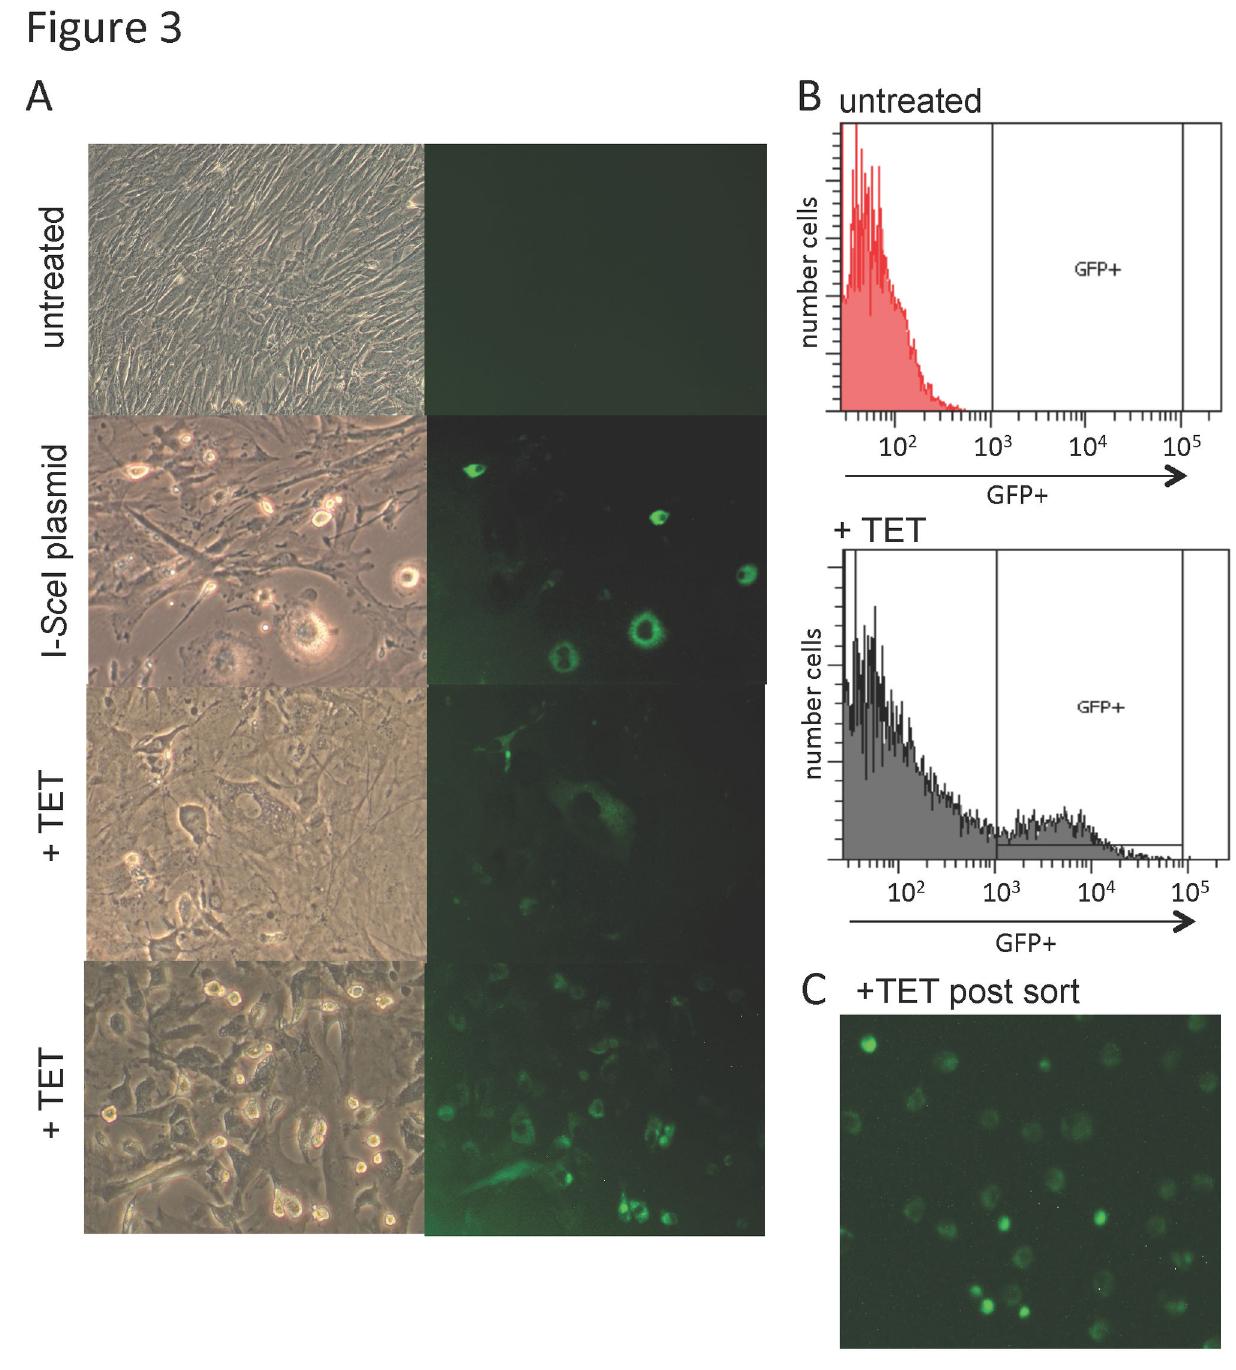
Figure 3. Analysis of GFP+ MEFs post-TET. ( A ) Phase contrast and matched fluorescent microscopy images of MEFs in culture —magnification 400X. Top row-untreated MEFs. Second row-96 hrs post-electroporation with I- Sce I expression plasmid. Third and fourth rows-96 hrs after addition of tetracycline to the culture medium (+TET). ( B ) Representative FACS plot of MEFs with GFP positivity in log scale on the x axis plotted against number of cells on the y axis. Upper plot--untreated MEFs. Lower plot-- +TET treated MEFs. In this sample, the GFP+ population is 12.4%. ( C ) Confirmation of GFP+ cells after FACS single cell sorting for GFP+ MEFs. Cells within the GFP+ gate indicated in B lower panel were sorted and then viewed by fluorescent microscopy— magnification 400X.